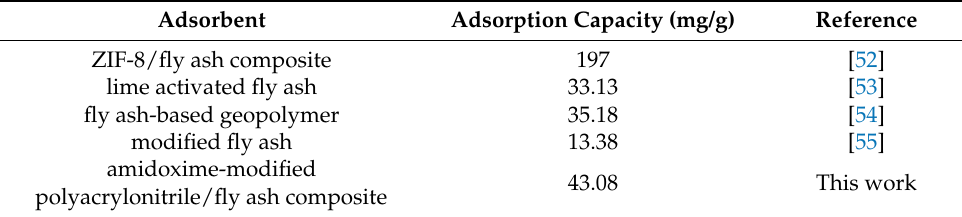
Figure 9. Linearized Langmuir isotherms obtained from Zn 2+ adsorption on amidoxime-modified polyacrylonitrile/fly ash composite. Table 2. Summary of Zn 2+ adsorption on fly ash according to references and present study.